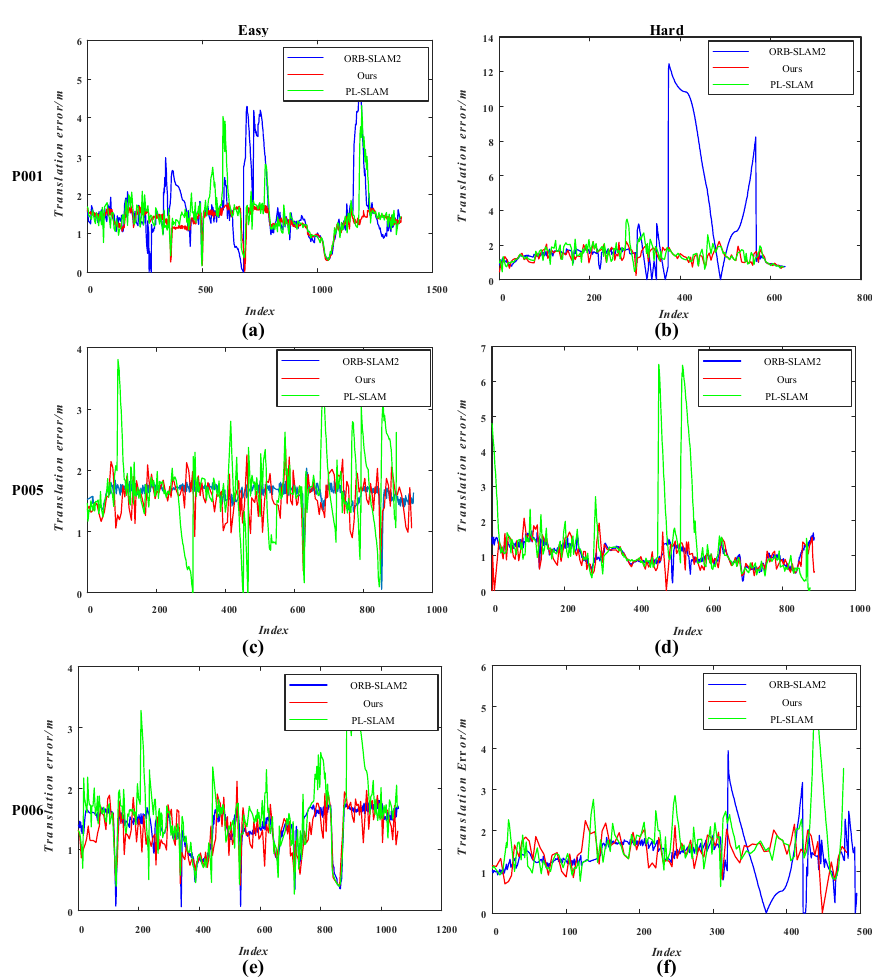
Figure 14. Mean relative pose error of translation on the TartanAir dataset. ( a , b ) are the t rel of different algorithms in Easy-P001, Hard-P001 sequences; ( c , d ) are the t rel of different algorithms in Easy-P005, Hard-P005 sequences; ( e , f ) are the t rel of different algorithms in Easy-P006, Hard-P006 sequences. The blue line, red line, and green line represent the relative pose error of translation for ORB-SLAM2, our approach, and PL-SLAM, respectively.